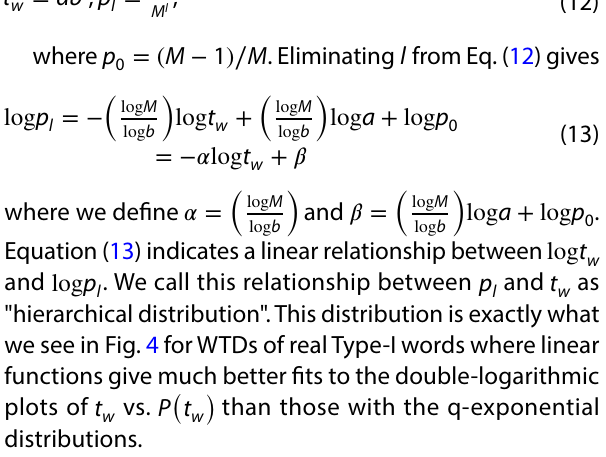
Table 2 Optimized fitting parameters of best fitted lines/curves shown in Figs. 4, which are for the words “capital”, “price”, “reve- nue”, and “trade” taken from the Smith text. Corresponding results for the simulated Type-I word, the occurrence pattern of which is Fitting function